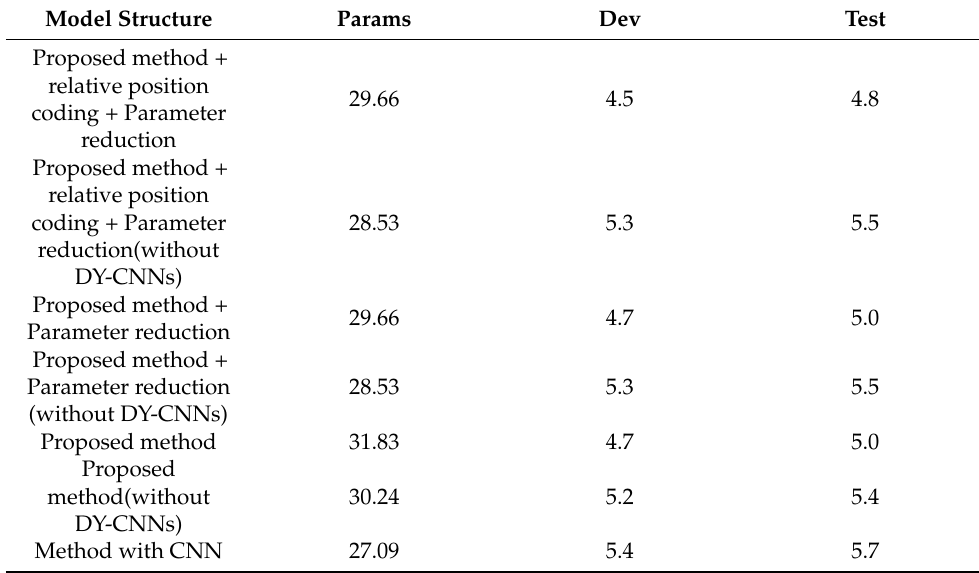
Table 5. Experiment results of parameter reduction.